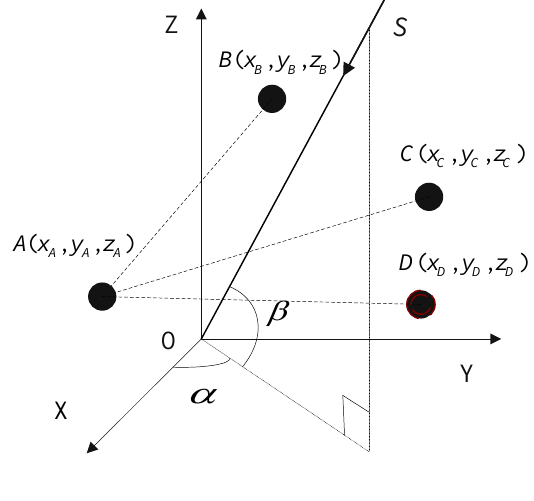
Figure 6. Four antennas direction finding